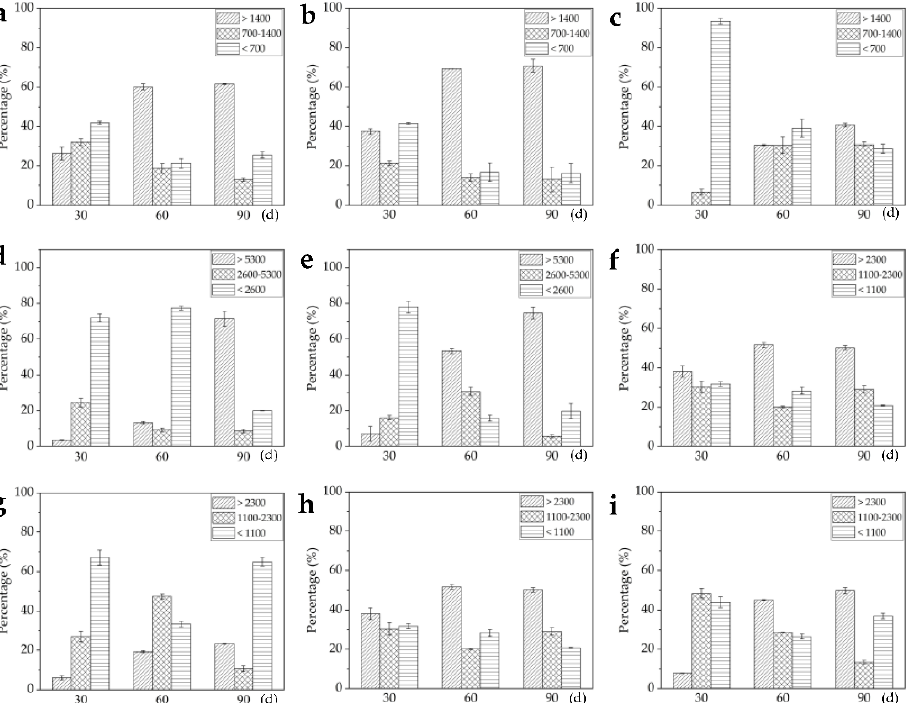
Figure 3. Area percentage evaluation of three alkaloids in plant tissues according to the image brightness intensities. ( a – c ) Area percentage of gelsemine, koumine, and gelsenicine in root in three intensity ranges (>1400, 700–1400, and <700); ( d – f ) area percentage of alkaloids in stem in three intensity ranges (>5300, 2600–5300, and <2600); ( g – i ) area percentage of alkaloids in leaf in three intensity ranges (>2300, 1100–2300, and <1100). The error bars indicate the standard deviations of three biological replicates. Statistical significance was evaluated using the Microsoft Excel software.